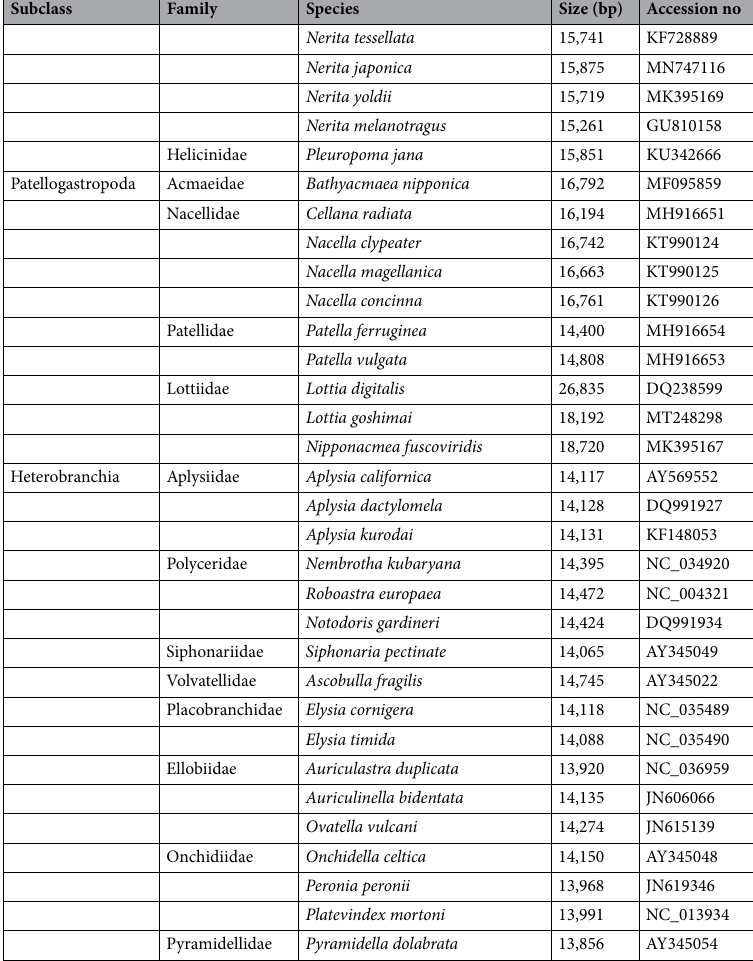
Table 1. List of species analyzed in this study and their GenBank accession